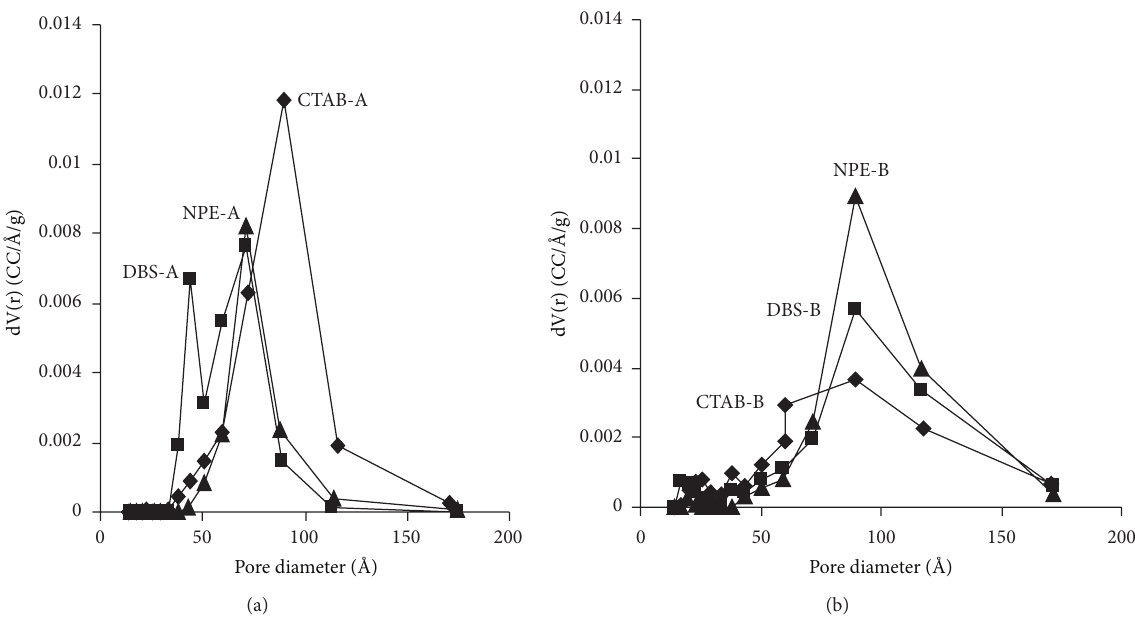
Figure 7: Pore-size distribution of TiO 2 in acidic and basic media.